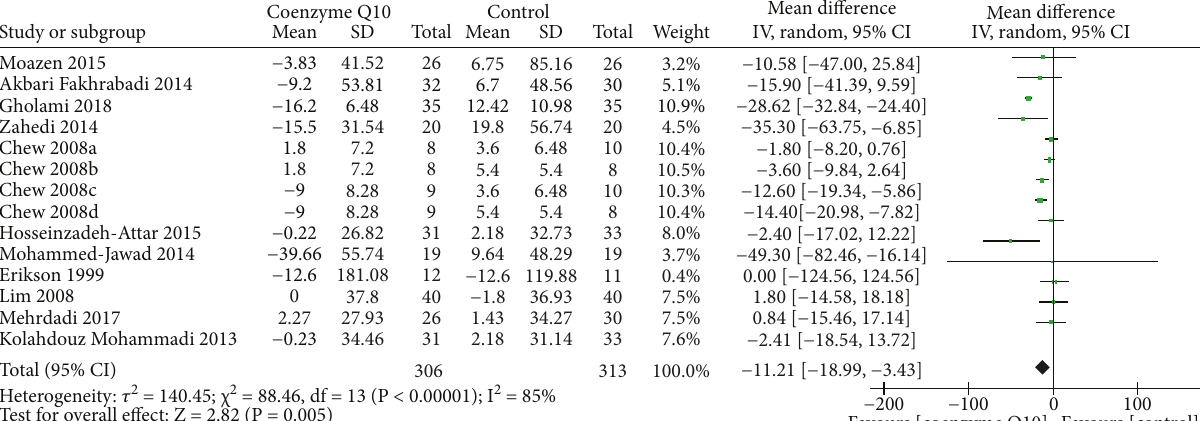
Figure 4: Fasting blood glucose.